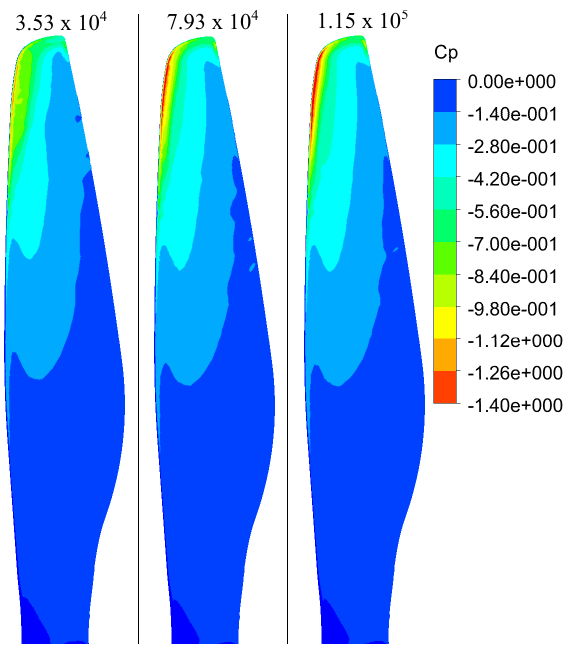
Figure 7. Pressure coefficient distribution on the upper surface of the rotor using the transition- turbulence